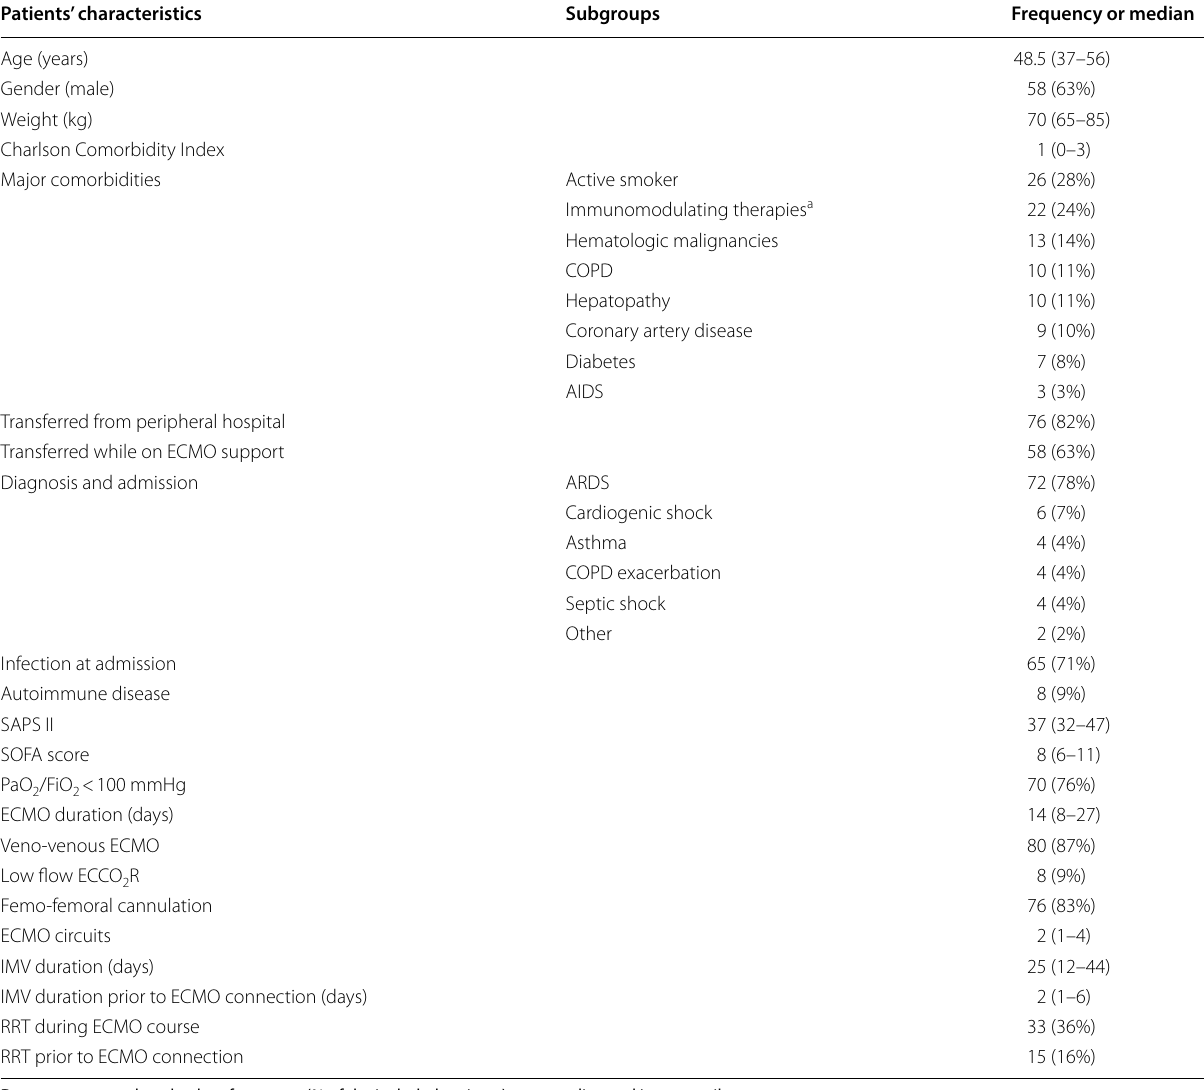
Table 1 Patients’ and treatment characteristics at the ECMO connection ( n